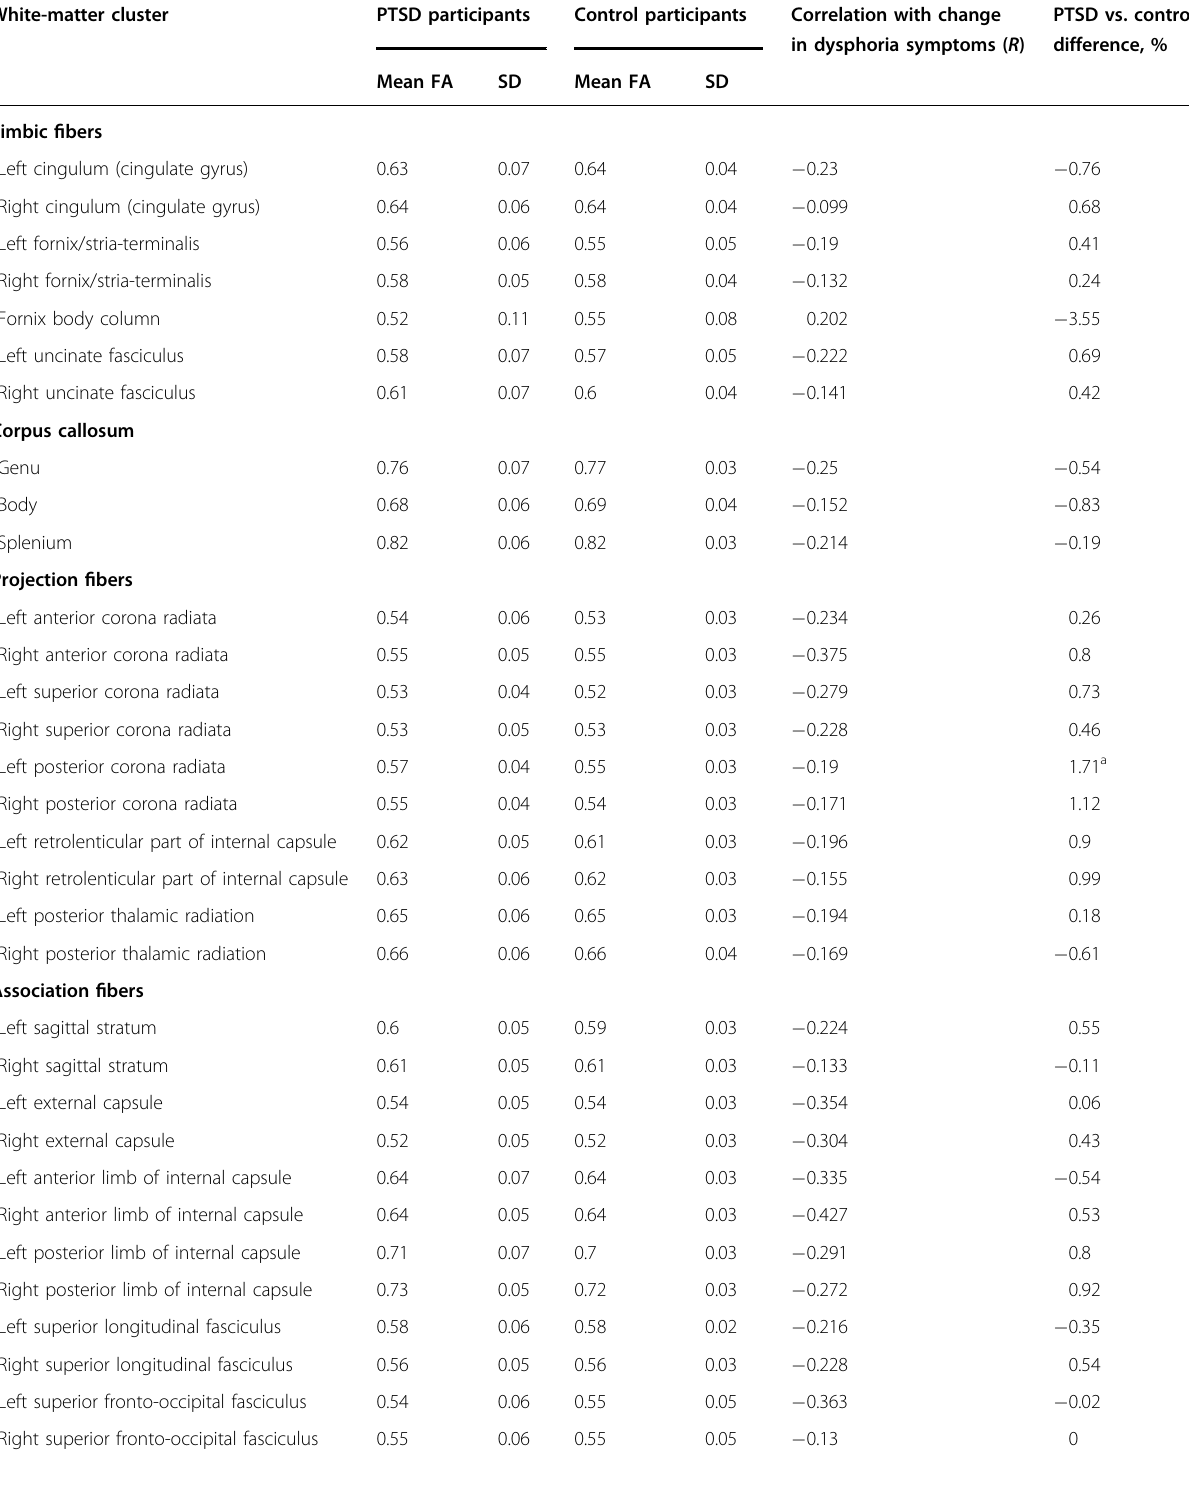
Table 2 White matter regions with signi fi cant fractional anisotropy associations with dysphoria symptom change. White-matter